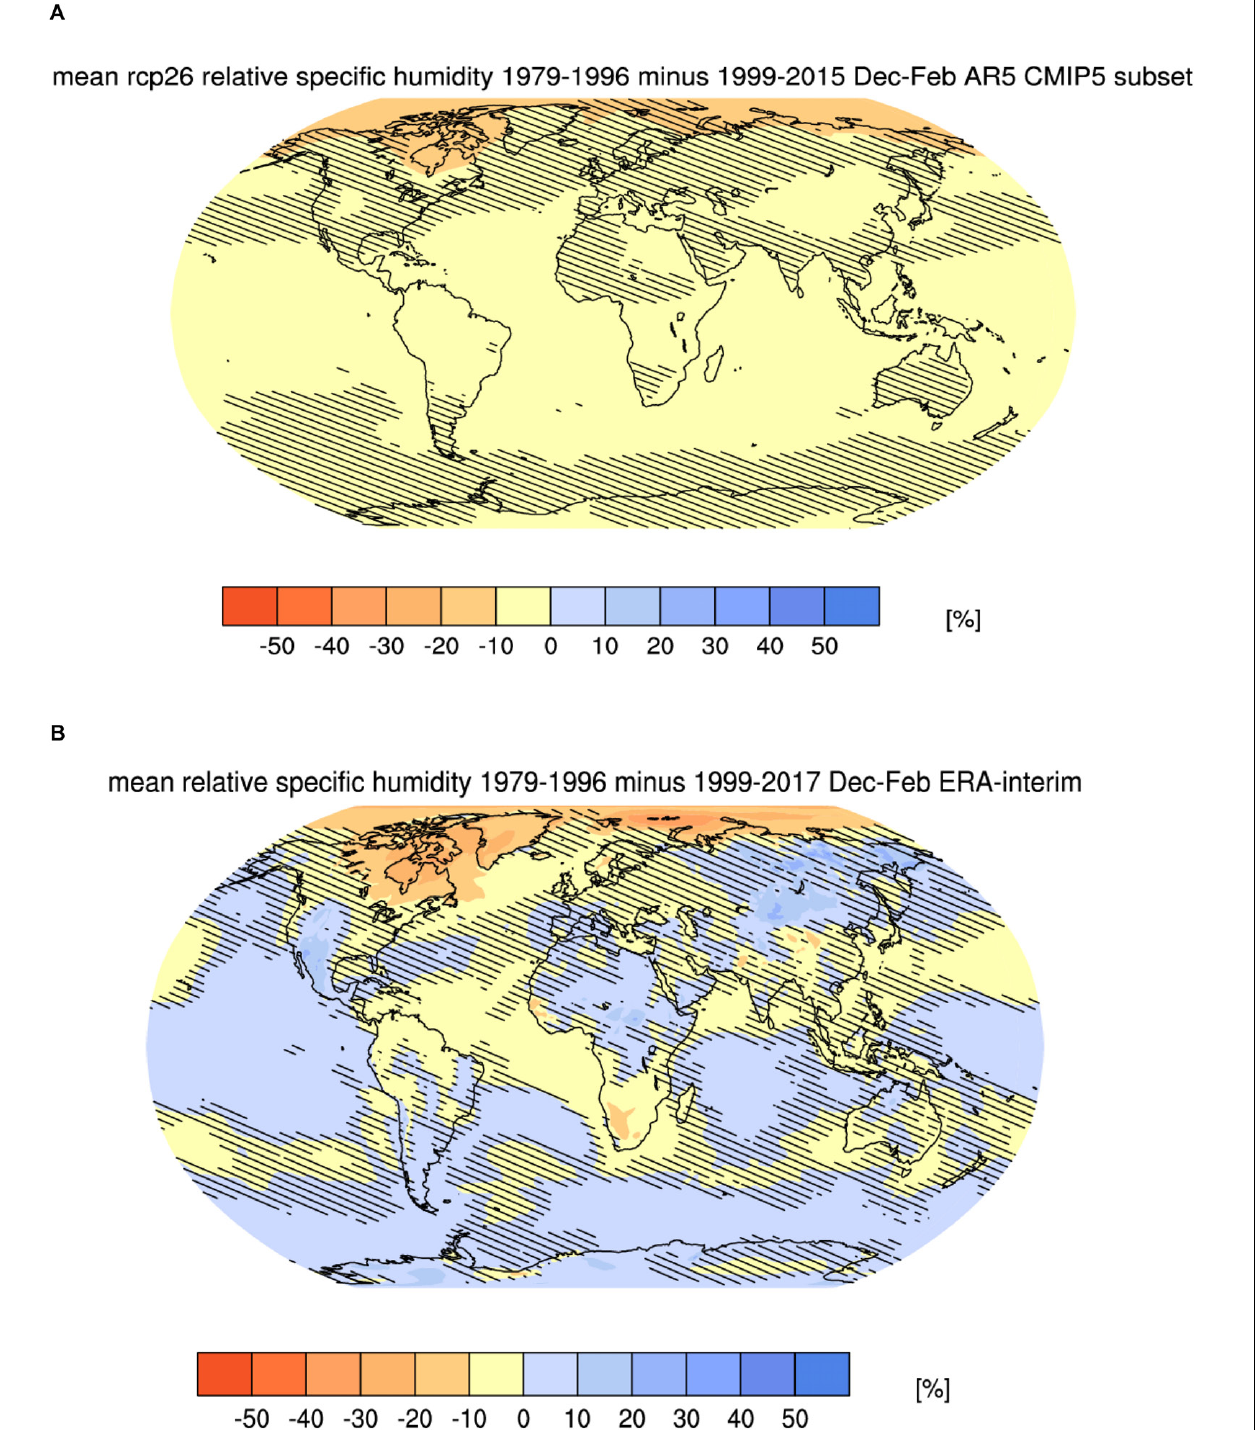
FIGURE 6 | Mean specific humidity anomaly (1979–1996 minus 1999–2017) for Dec-Feb from (A) AR5 CMIP5 subset models and (B) ERA-interim data. It started from 1979 instead of 1976 because ERA-interim data are only available since then. Areas with signal smaller than one standard deviation of natural variability is shown by hatching. Plots generated using the IPCC’s Climate Change Atlas; climexp.knmi.nl/plot _atlas_form.py. Note here the reverse color bar.